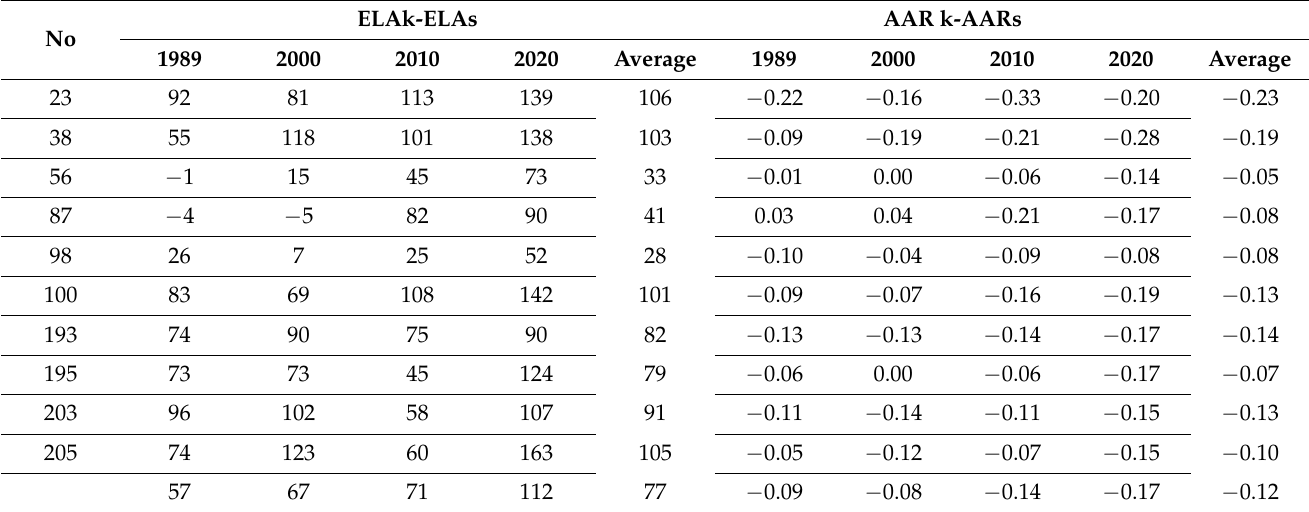
Table 3. Comparison of the results of ELA and AAR estimation by Kurowski method and obtained from satellite imagery,